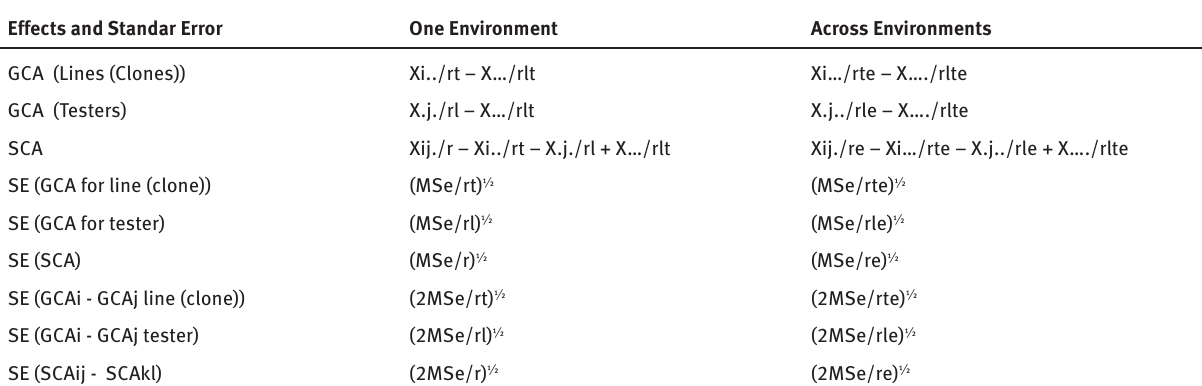
Table 3: Formulas to estimate the effects of combining ability (GCA and SCA) and its standard error (SE)